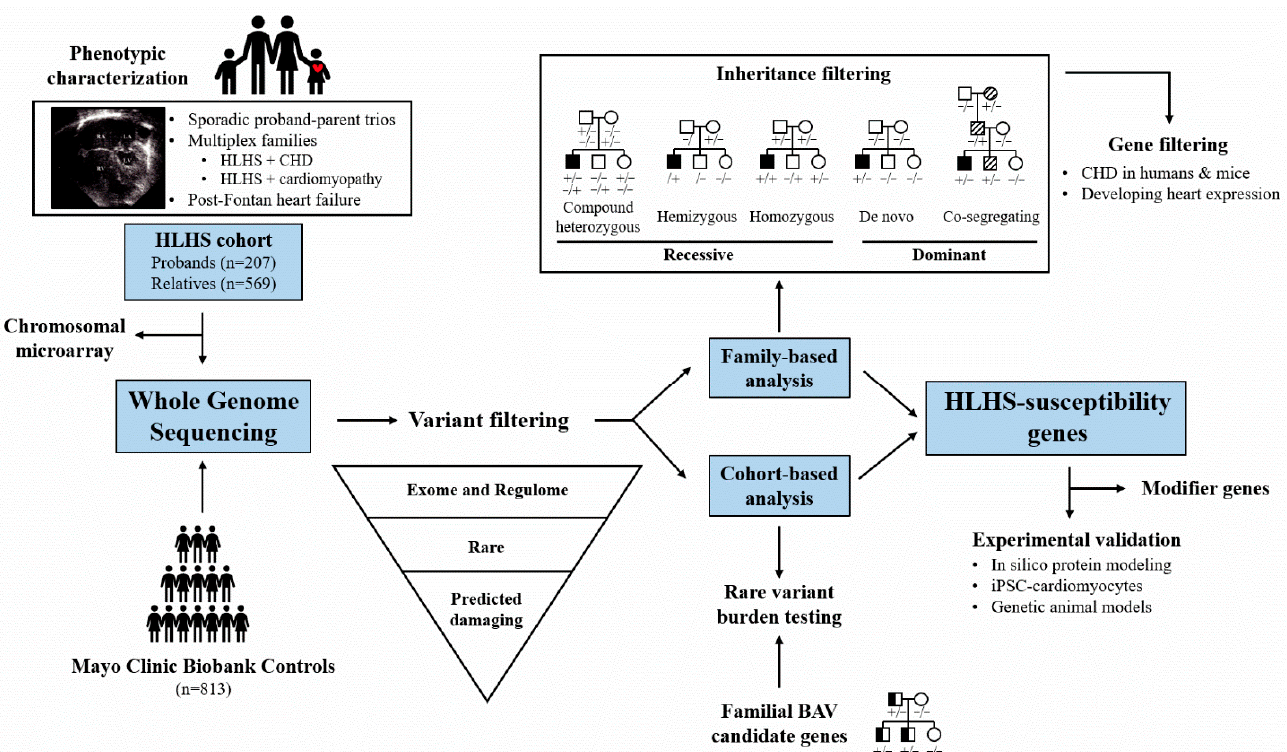
Figure 1. Whole genome sequencing and variant filtering algorithm. Depicted in the pedigrees are individuals with HLHS (black symbol); BAV (half symbol); cardiomyopathy or other CHD (diagonal stripes); family members without structural or myopathic heart disease (white symbol). Genotypes indicate presence (+) or absence ( − ) of a variant. Table 1. Bioinformatics databases and tools.